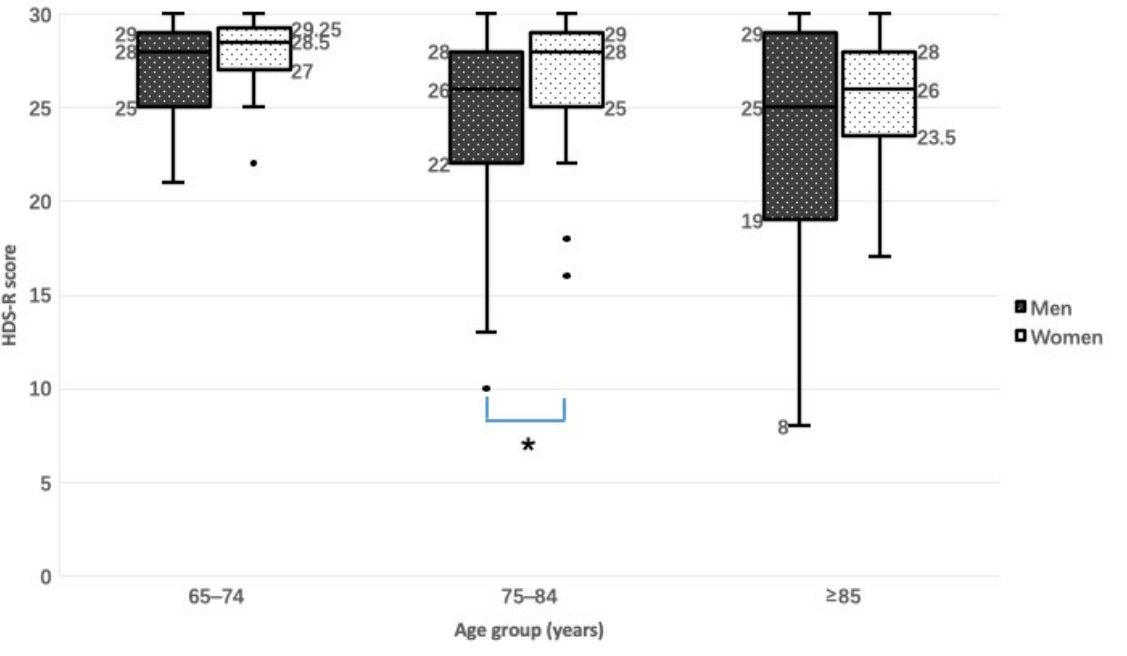
Figure 2. Relationship between HDS-R score and sex by age group. * p = 0.044, two-sided Mann– Whitney U test. Table 3. Sex differences for total score and individual item score on the